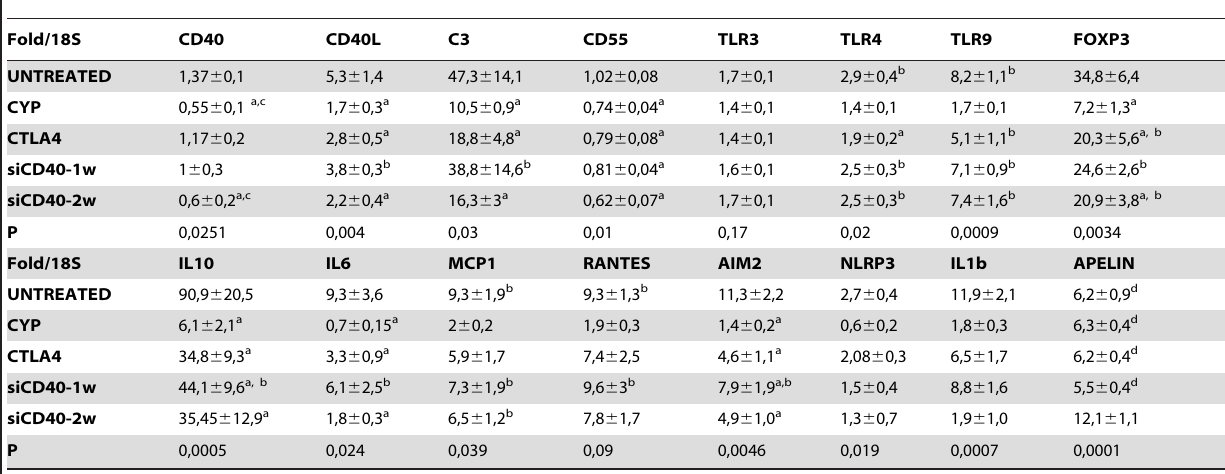
Table 1. Kidney gene